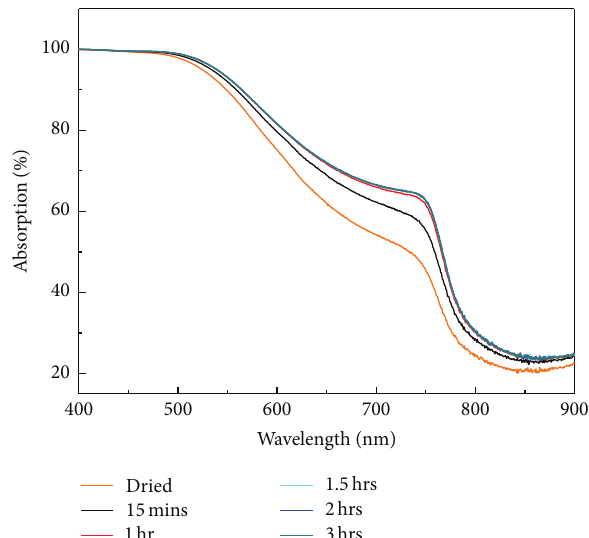
Figure 2: Overlaid absorption spectra of lead-based perovskite films. Films were dried at 75 ∘ C for 15min and then annealed at 105 ∘ C with varying annealing times. Reproduced from [21] with permission from the Royal Society of Chemistry.